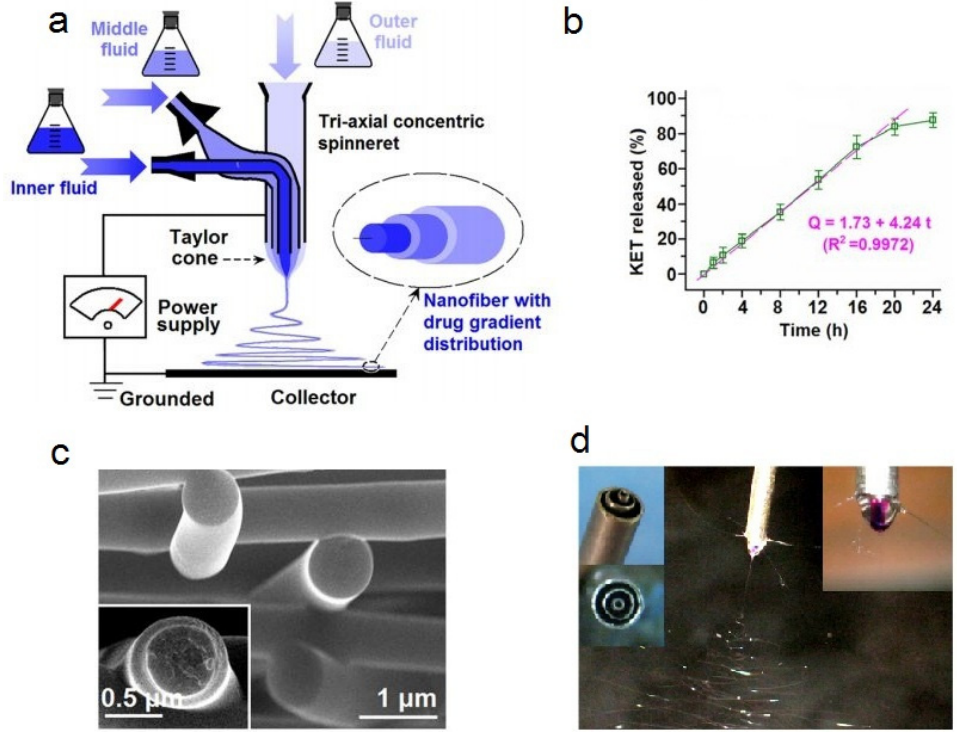
Figure 17. ( a ) Scheme of triaxial electrospinning; ( b ) kinetic profile of ketoprofen release over time from tiraxialy electrospun fibers; ( c ) cross sectional morphology of triaxial fibers and ( d ) digital photograph of triaxial electrospinning process (reprinted and adapted from Applied Materials and In- terfaces , 2015 , 7 , 33, 18891–18897, Yu, D.G.; Li, X.Y.; Wang, X.; Yang, J.H.; Bligh, S.W.A.; Williams, G.R. Nanofibers Fabricated Using Triaxial Electrospinning as Zero Order Drug Delivery Systems, Copy- right 2015, American Chemical Society).